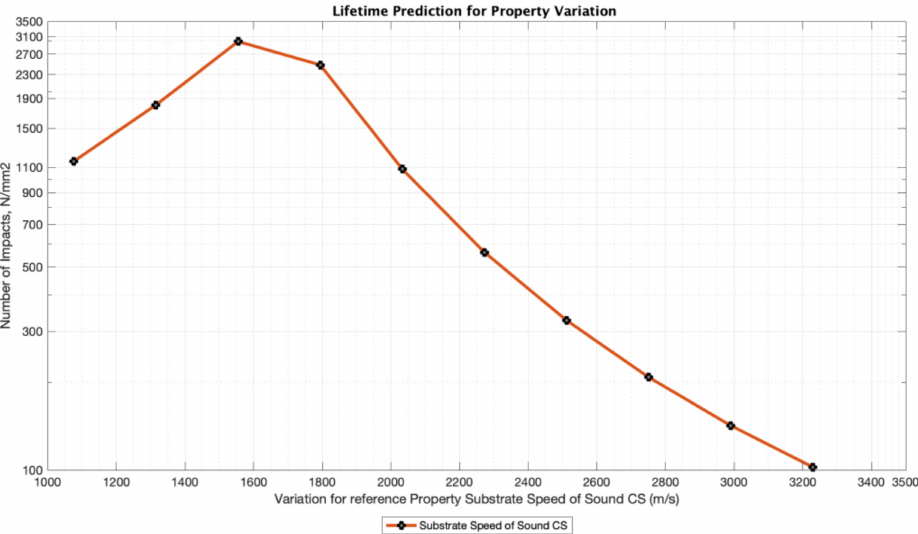
Figure 19. Incubation time estimation due to a unique variation of the substrate (primer or filler) wave speed Cs.